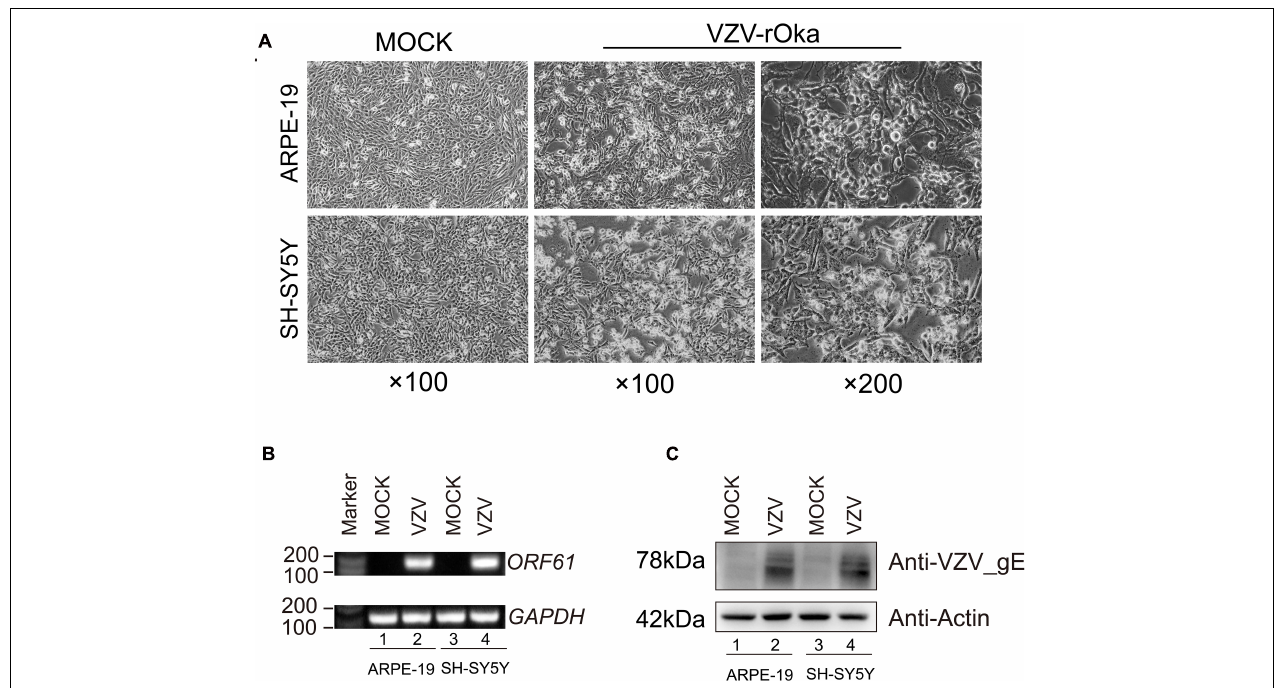
FIGURE 1 | ARPE-19 and SH-SY5Y cells infected with VZV induced obvious cytopathic changes. (A) ARPE-19 and SH-SY5Y cells infected with VZV for 48 h induce obvious cytopathic changes, and cells not infected with (MOCK) virus maintain normal morphology and growth. (B) Real-time quantitative PCR was used to measure the expression of ORF61 encoding the early phosphorylation protein of virus in ARPE-19 cells and SH-SY5Y cells after 48 h of VZV infection. (C) Western blot was used to evaluate the expression of VZV glycoprotein gE in ARPE-19 cells and SH-SY5Y cells.